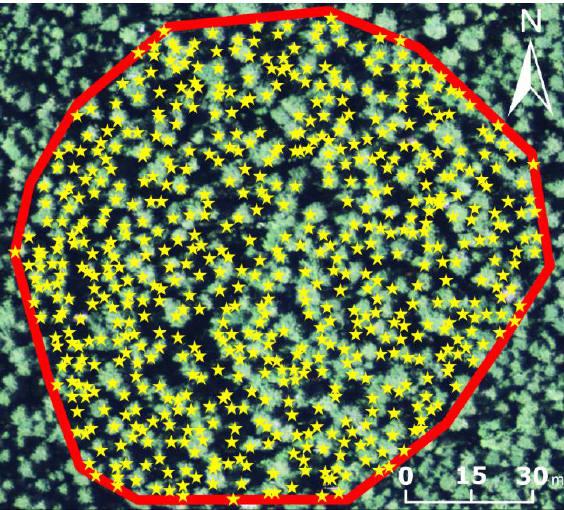
Figure 4. Georeferenced possible trees estimated with TrEx from the above canopy point cloud (red stars). The background image is the orthophoto, which does not necessarily align with the point cloud. The total number of trees extracted by TrEx from the normalized PPC was 641 trees; out of which few are not necessarily actual trees, but branches mistakenly identified as trees. The initial location of each tree was selected to be the coordinates of the highest point within the crown. Once the trees were extracted, TrEx delineated their crown by tracing the pixels identified within the oriented weighted graph as belonging to neighboring trees. The final coordinates of the trees segmented from the above canopy PPC were determined using the lower quartile of the points above 2 m that were located inside the circle centered in the initial tree location and with radius computed with Equation (1). The final coordinates differ, on average, 0.45 m from the initial tree coordinates (i.e., coordinates of the highest point within the crown), as computed by TrEx. The differences range from 0.1 m to 1.7 m. The parameters used to reconstruct the PPC from below-canopy images were based on Fang and Strimbu [23], but adjusted to produce fast results, less than 1 min per location. Therefore, to align the images we have used only ⅟ 16 × ⅟ 16 of each image (i.e., accuracy set to low), 40,000 key points, and 5000 tie points (Figure 5). Once the images were aligned, we densified the tie points by filtering the outliers assuming a lack of small meaningful details and ¼ of the linear information stored in each image. We integrate the PPCs generated at each location by first aligning them with the scale- invariant feature transform [57], and second by merging them.